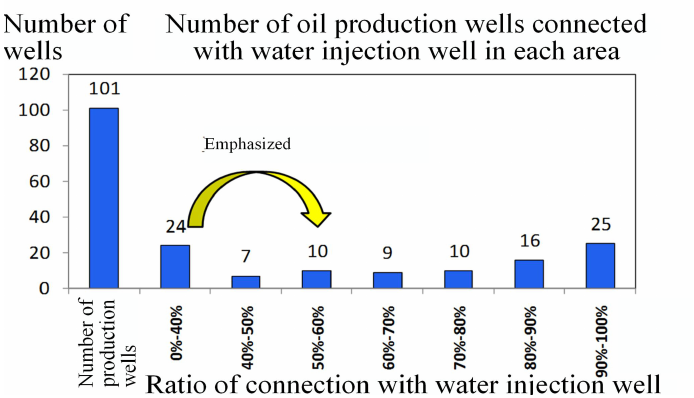
Figure 11—Distribution of production-injection connection ratio.